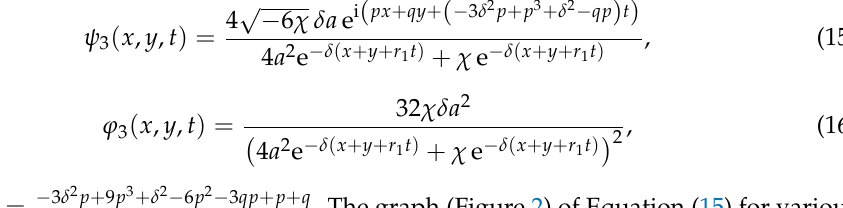
parameters is given below.